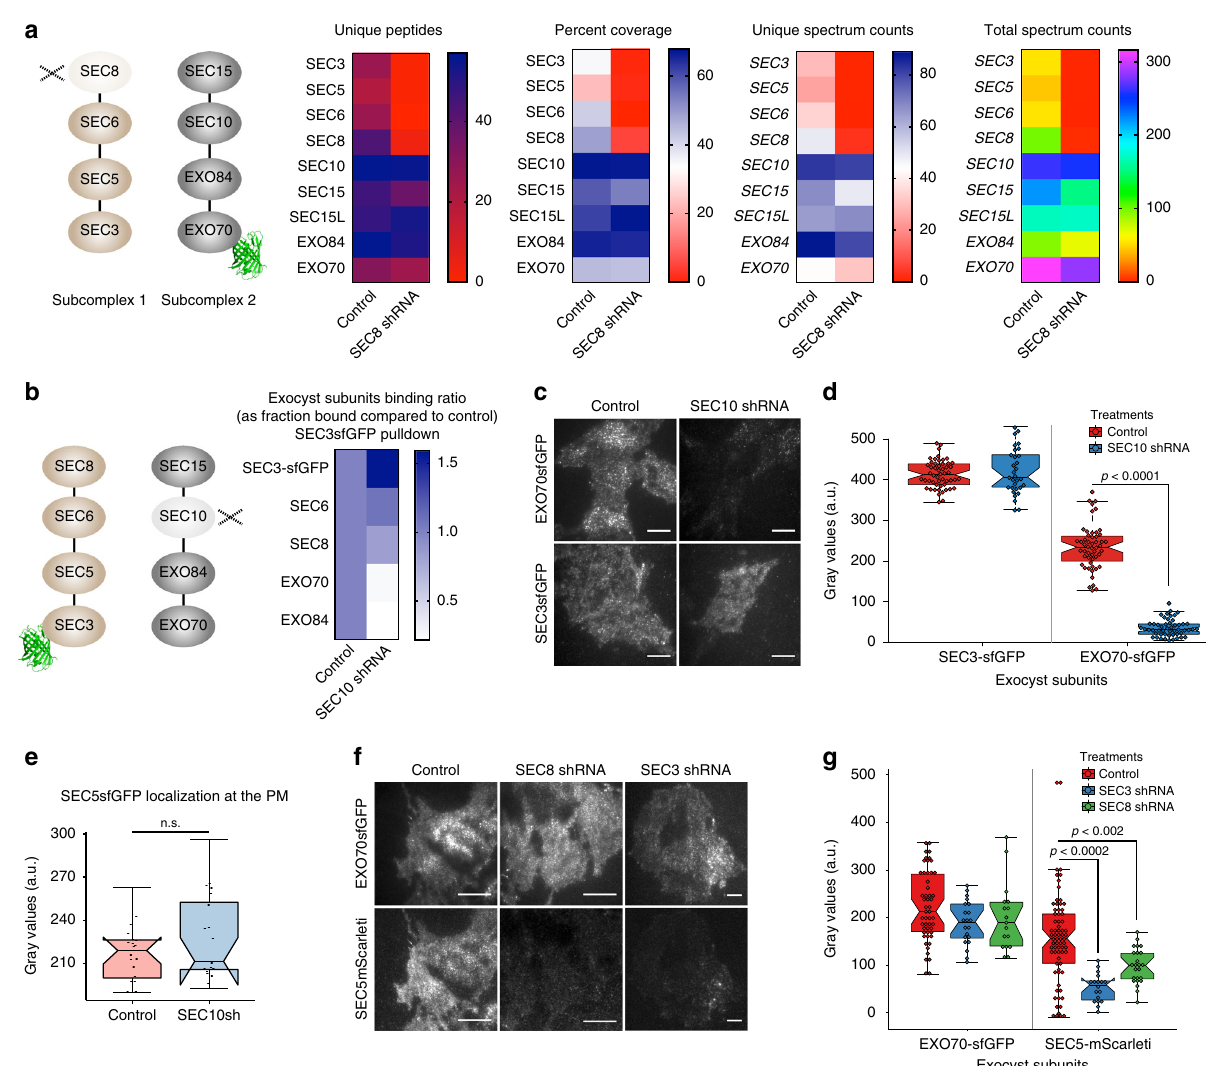
Fig. 2 Mammalian exocyst complex comprises two subcomplexes that can localize to the PM independently. a Quantitative full-scan LC – MS/MS analysis of endogenous EXO70-GFP pulldowns from intact or Sec8-depleted cells. Inputs for the samples were calibrated and normalized using MRM – MS analysis on the same samples. The schematic shows the experimental design in which EXO70-GFP was captured using GFP-Trap beads and SEC8 was depleted by shRNA. b Heatmap summarizing relative binding of SEC6, SEC8, EXO70, and EXO84 to SEC3-GFP in SEC10-depleted cells compared to control shRNA- treated cells, as assessed by western blot. Also see Figure S2H-I. c TIRFM images of EXO70-GFP and SEC3-GFP in control or SEC10 shRNA-treated